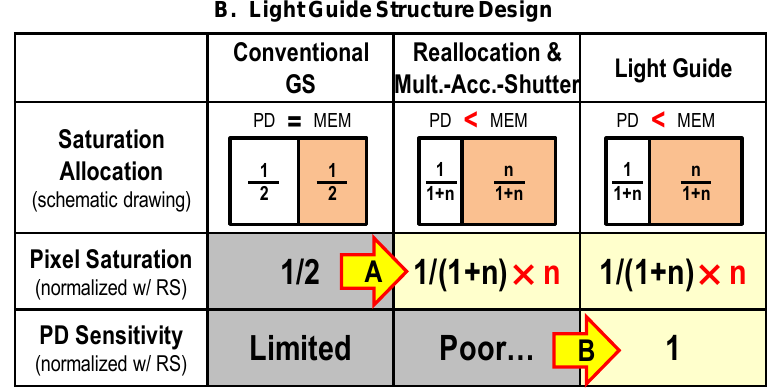
Figure 4. Key techniques.